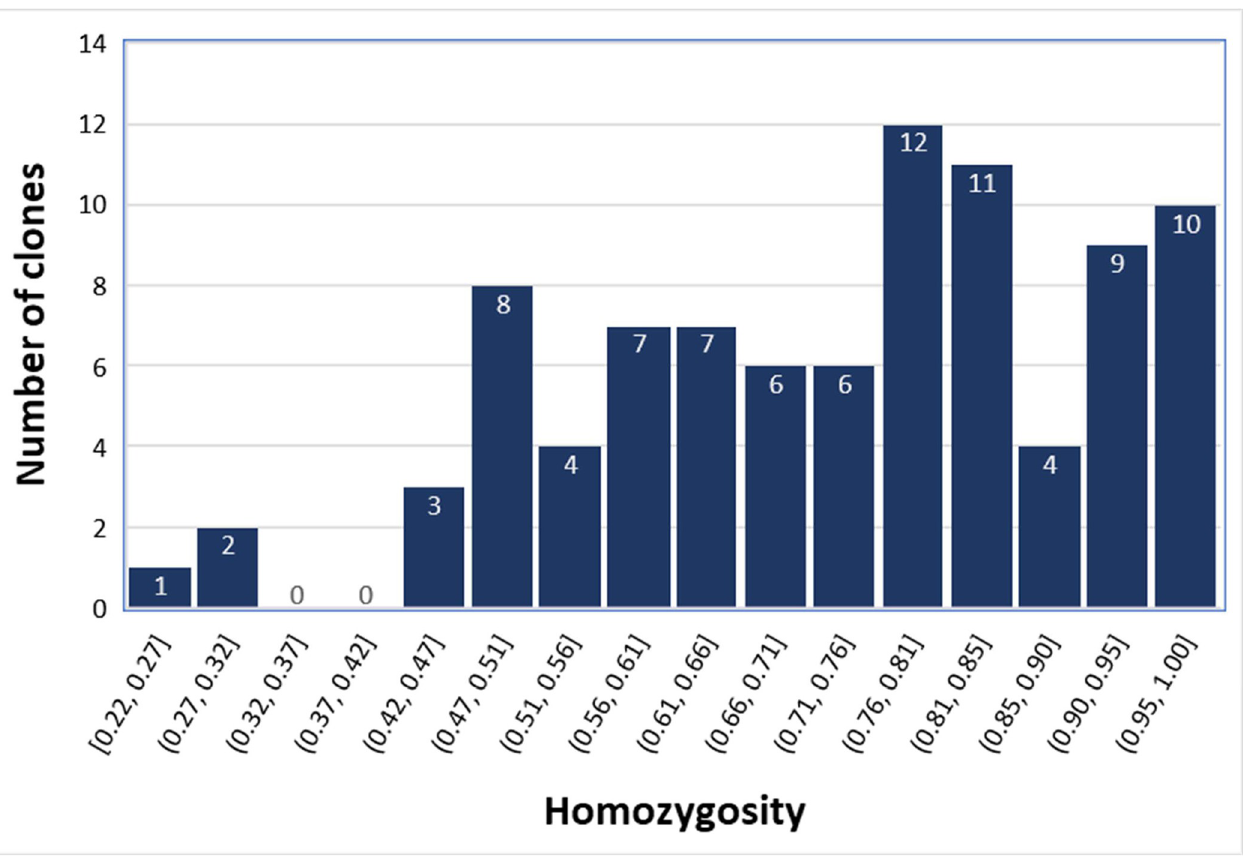
Fig 2. Distribution of the genome-wide homozygosity of the 90 cacao clones at the 3,380 sampled SNP.